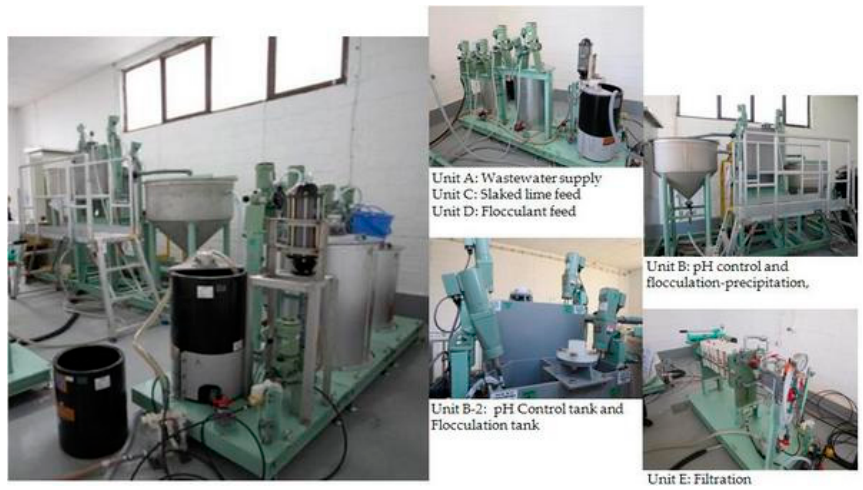
Figure 2. Semi industrial plant for two-step neutralization treatment.